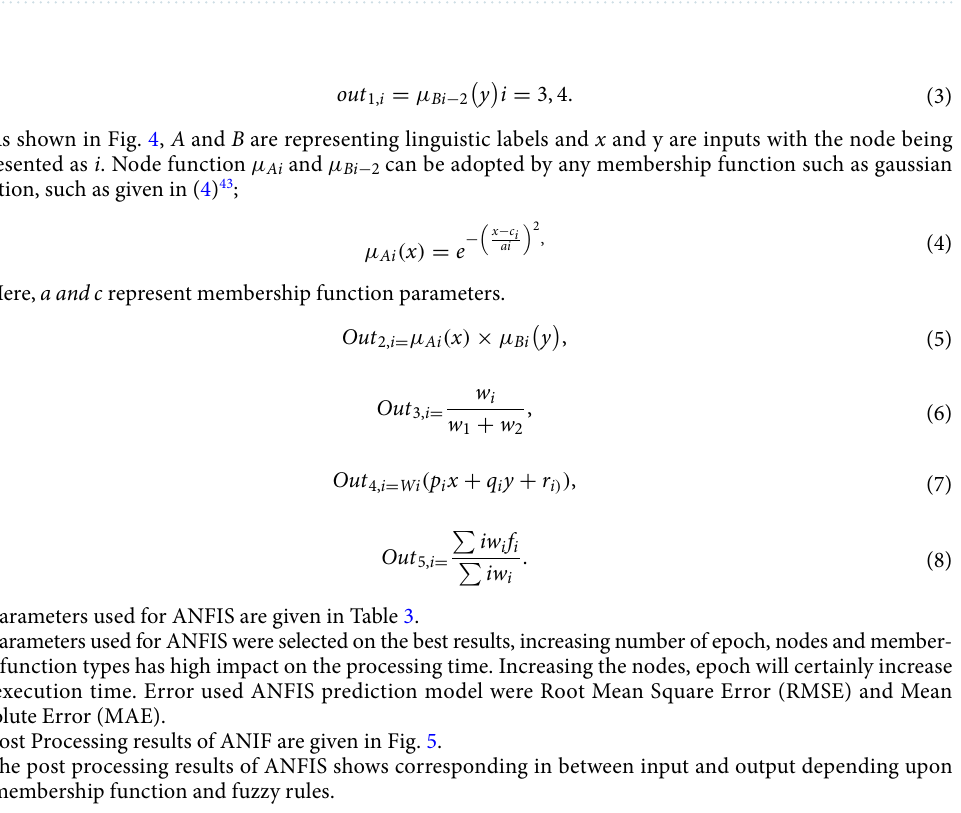
Table 3. ANFIS parameters used in the proposed